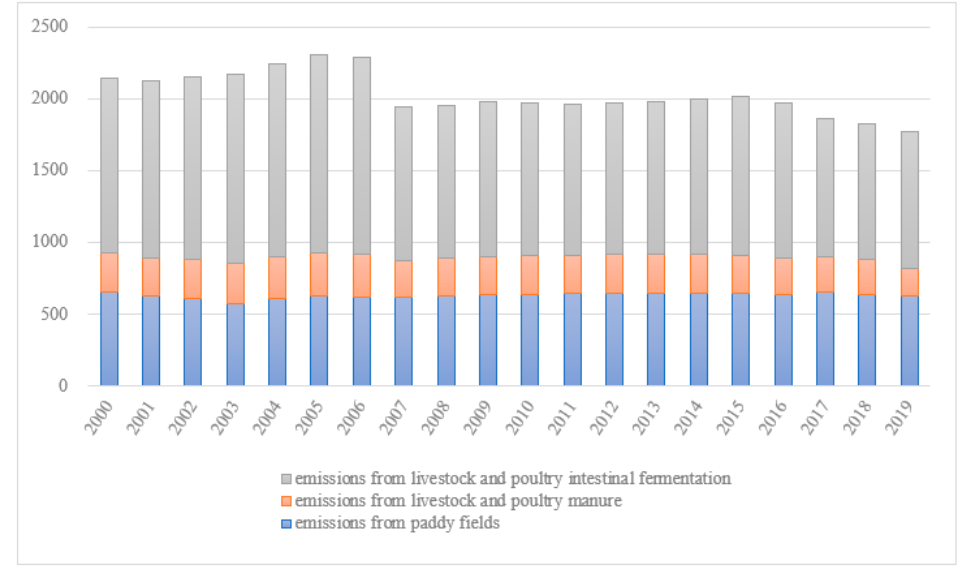
Figure 1. Agricultural methane emissions in China, 2000–2019.